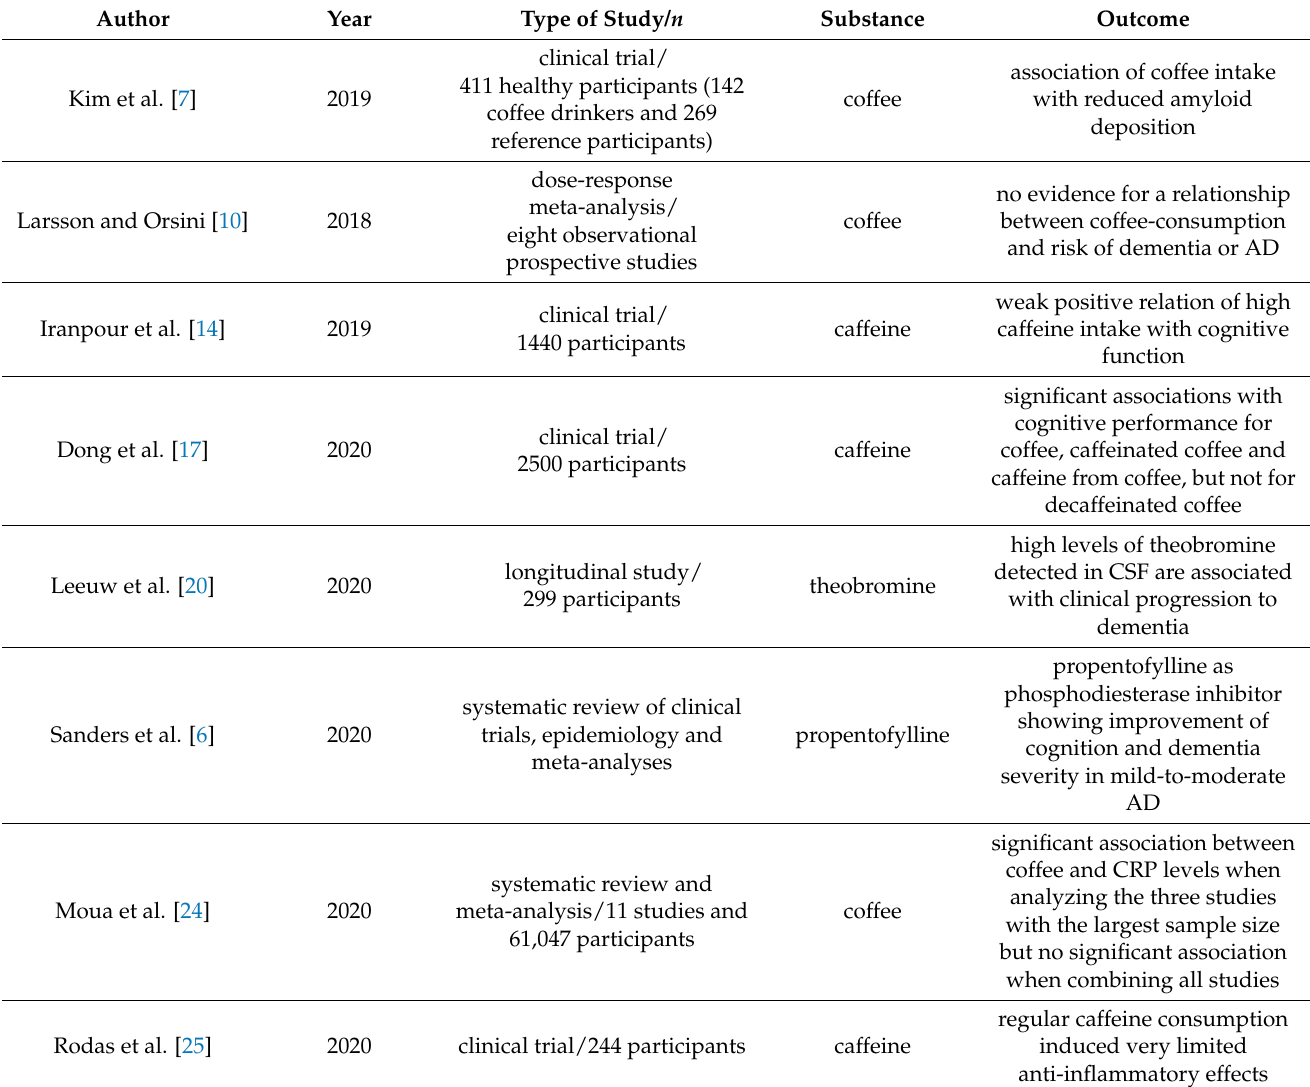
Table 1. Summary of recent clinical studies investigating the relationship between methylxanthines and Alzheimer ´ s disease (AD). n : sample size; CSF: cerebrospinal fluid; CRP: c-reactive